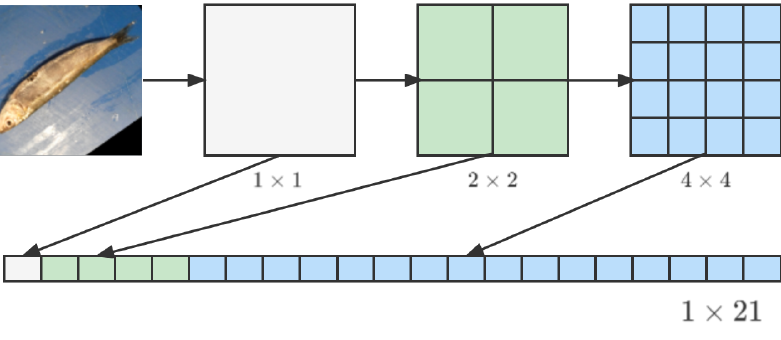
Figure 1. Illustration of spatial pyramid pooling